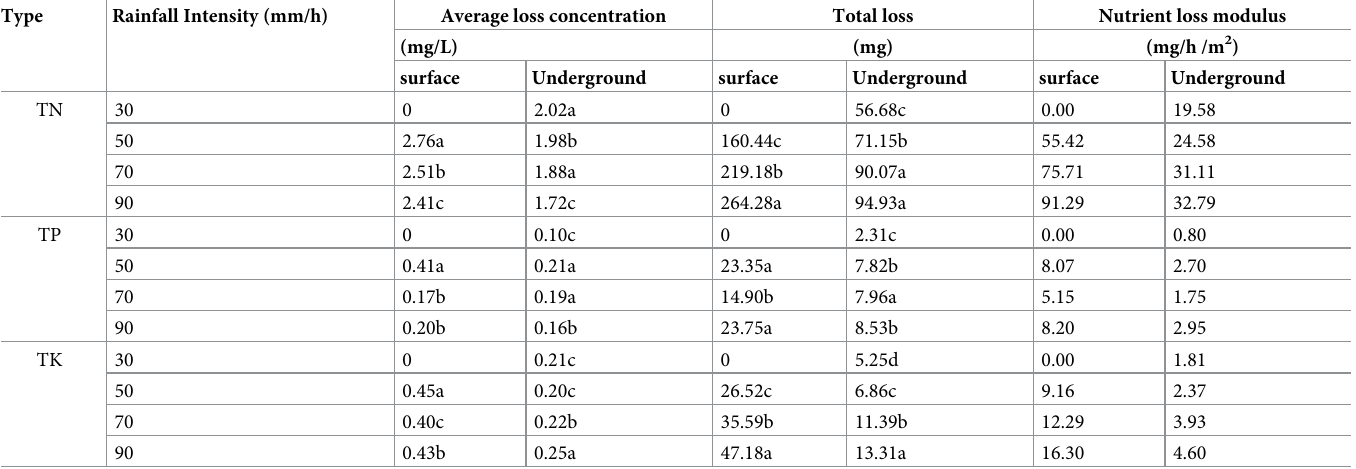
Table 3. Surface and underground runoff loss characteristics under different rainfall